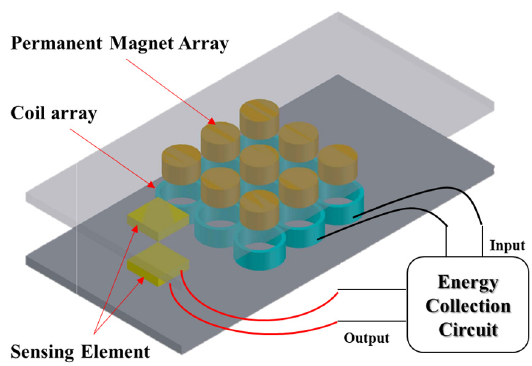
Figure 1. The system diagram.